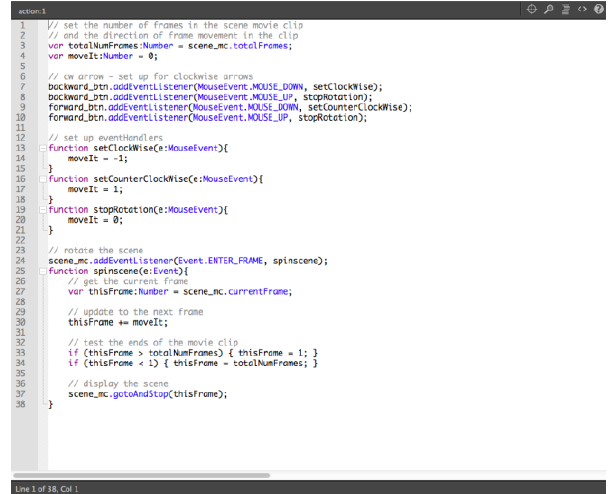
Figure 8: Codes in action scripts.